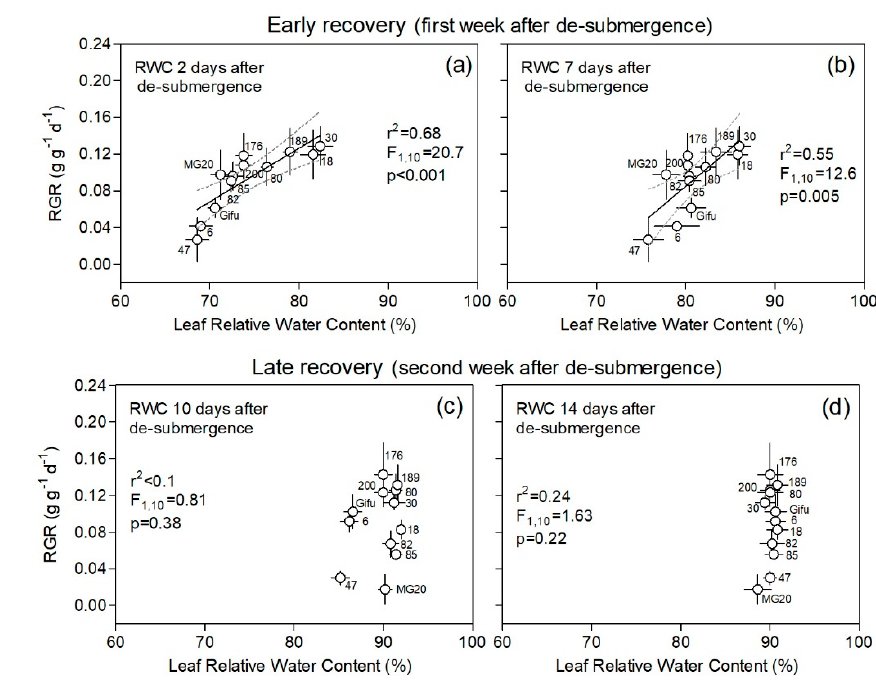
Figure 4. Plant relative growth rate (RGR) during ‘early’ and ‘late’ recovery vs. relative water content (RWC, %) on the top-most fully expanded leaves at days 2, 7, 10, and 14 after de-submergence for plants of 12 genotypes of Lotus japonicus (10 recombinant inbred lines and their parents Gifu and MG20). The first week after de-submergence was used to explore the relationship between these variables in an ‘early recovery’ phase ( a , b ) and the second week in a ‘late recovery’ phase ( c , d ). Values are means ± standard errors (n = 6–8 for RGR and n = 5 for leaf RWC). The leaf RWC values corresponding to the control treatment ranged between 89.2% and 92.4% (all data for each genotype and measurement dates are available in Table S2).